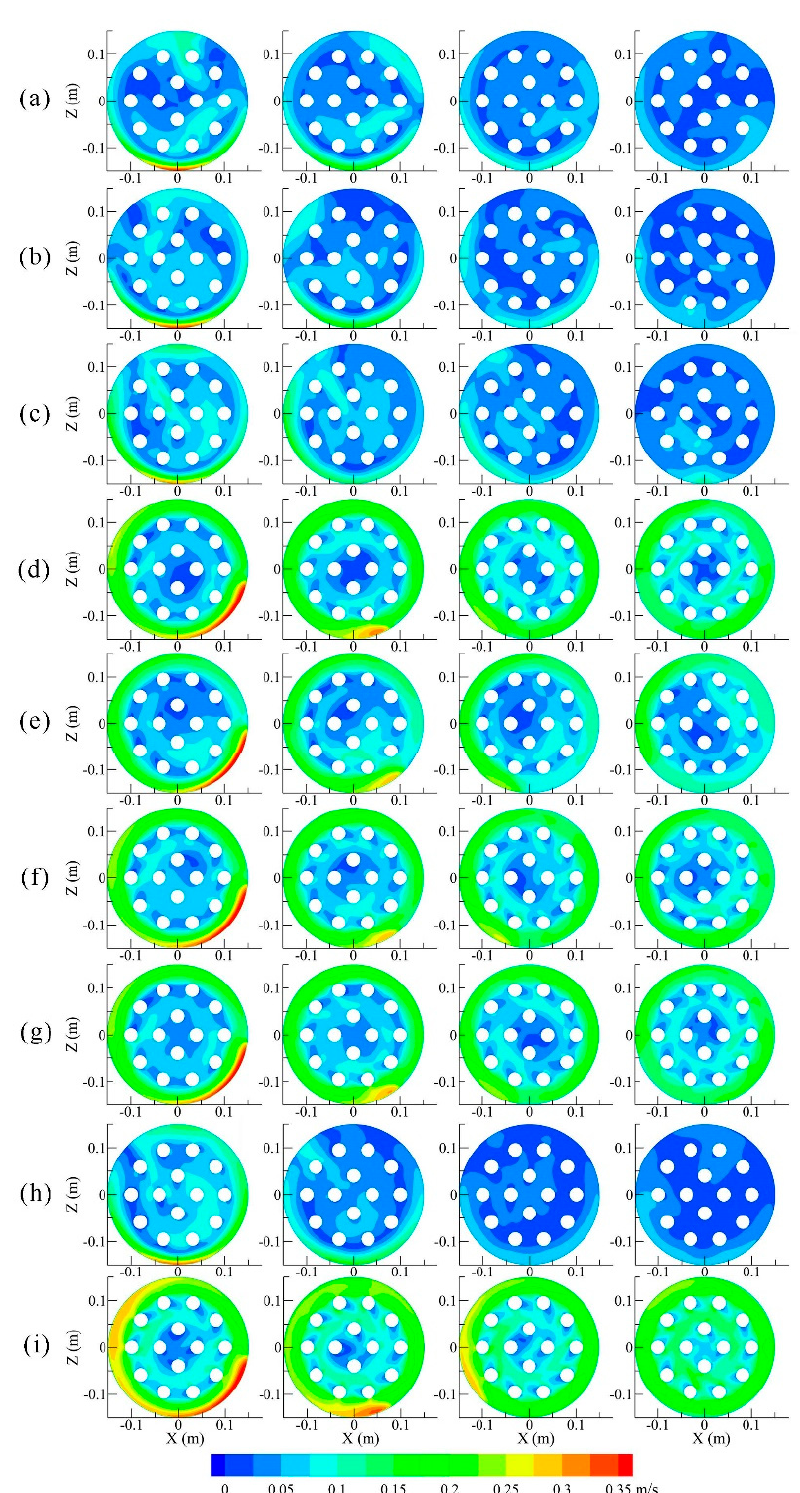
Figure 4. Contours of liquid velocity at sections 1, 2, 3, and 4 under different conditions ( a – i ).